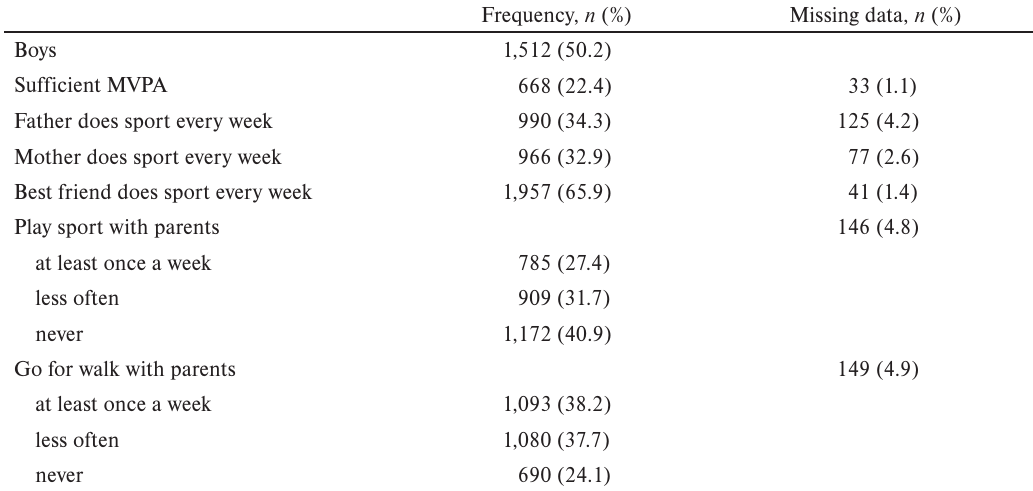
Sample description – frequencies (3,012 Slovak adolescents aged 12.5–16.0 years approached in 2014 within HBSC study)